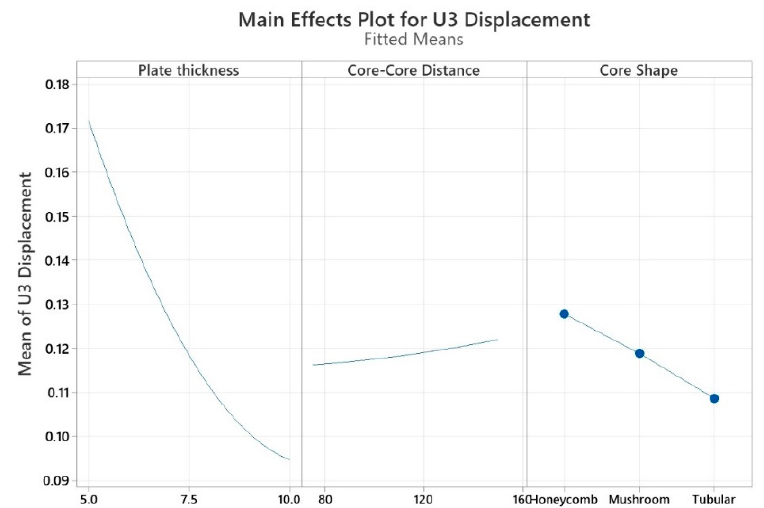
Figure 23. Main effects plot for sandwich panel displacement.